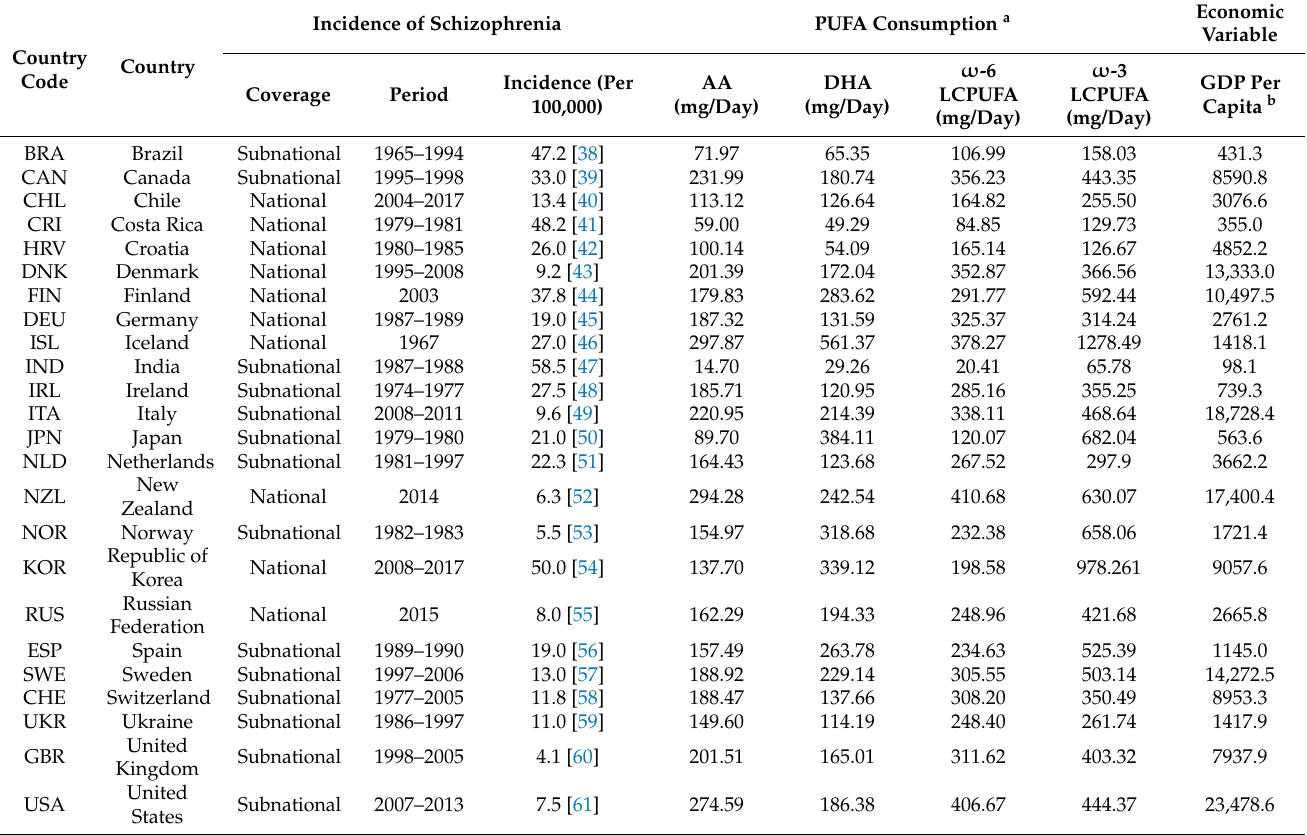
Table 2. The incidence rates of schizophrenia, PUFA consumption, and economic development across different